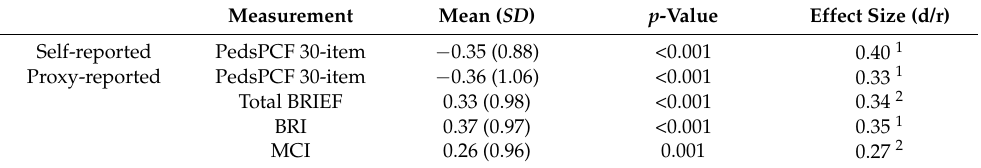
Table 2. Self- and proxy-reported scores on perceived cognitive functioning and proxy-reported scores on executive functioning compared to population means.